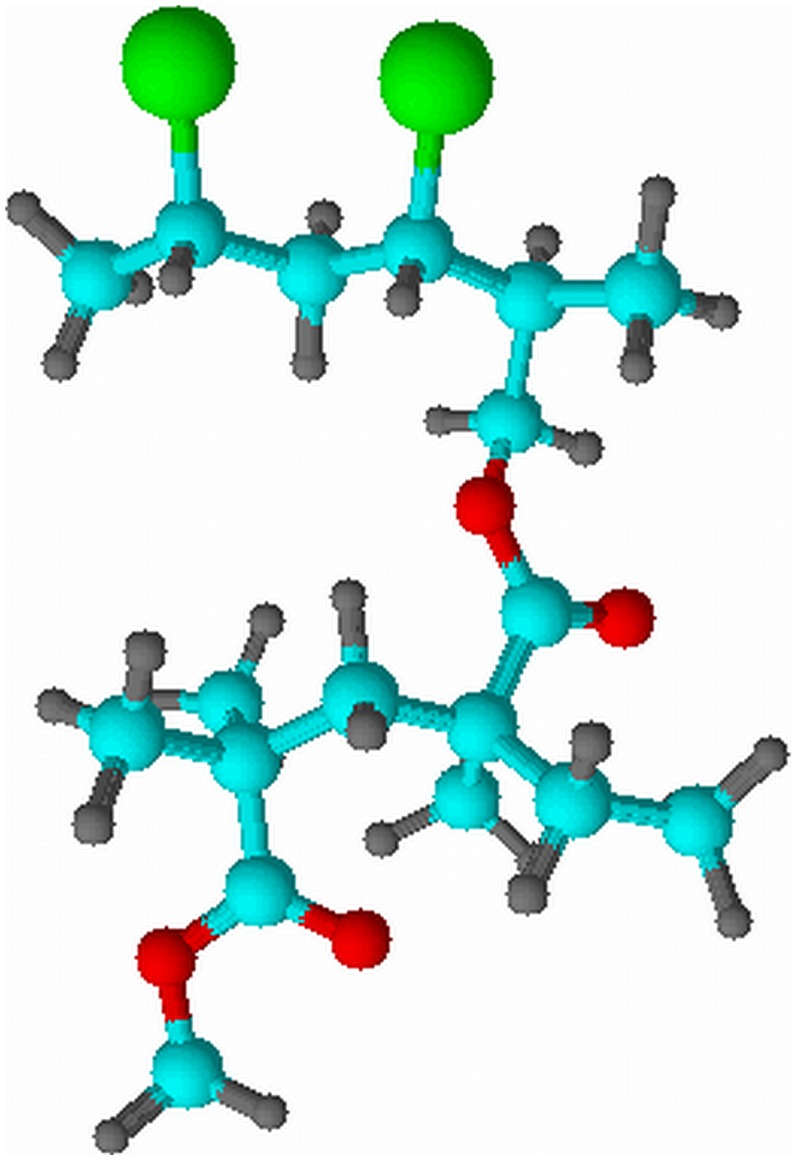
The cross–linkage between PMMA and PVC.